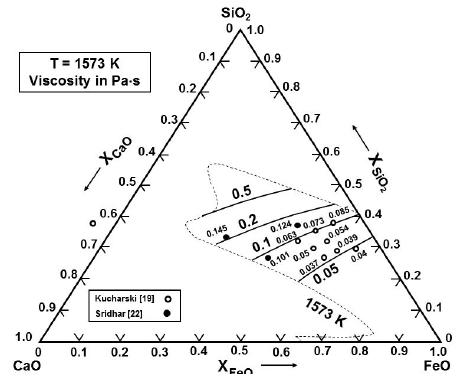
−CaO−FeO melts at 2